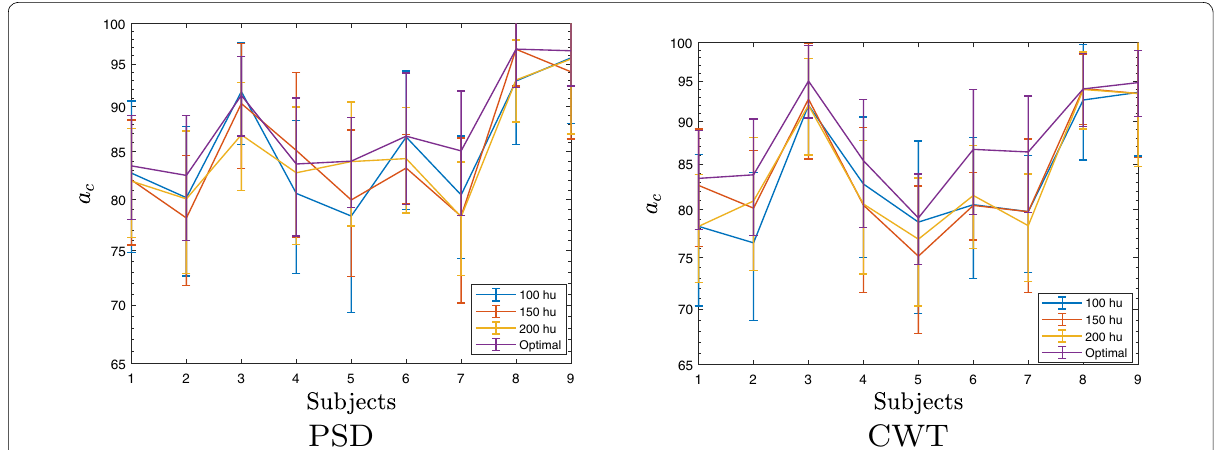
Fig. 2 Dependence of CNN hidden units and the individual bi‑class accuracy. Label “optimal” is the individually tuned CNN